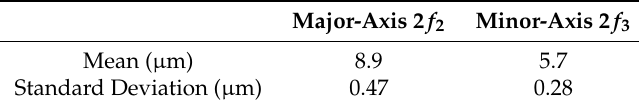
Table 3. Measured fiber